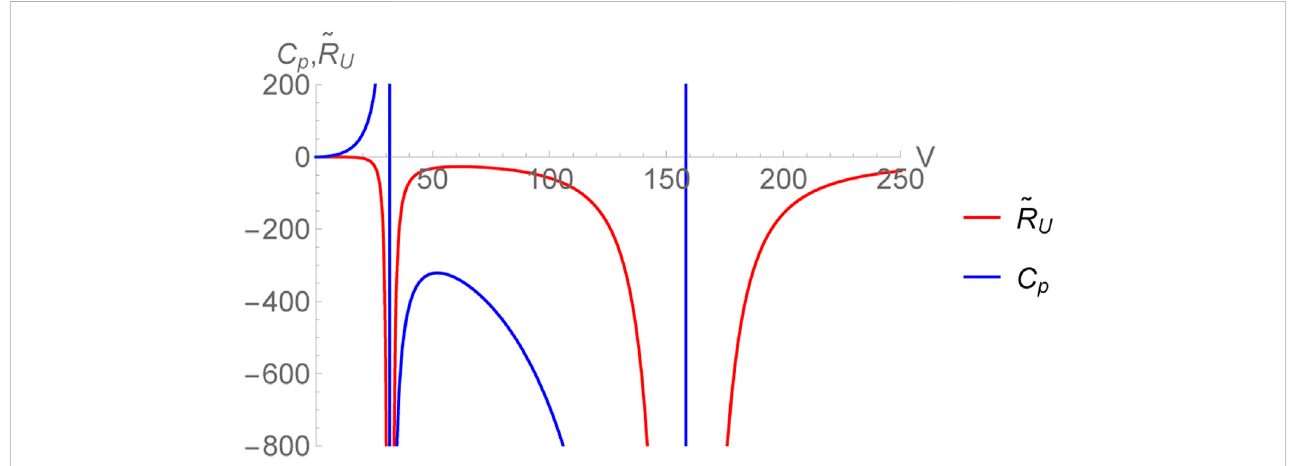
FIGURE 2 Normalized thermodynamic curvature ~ R U for the RN-AdS black hole and speci fi c heat C P plotted versus thermodynamic volume V with q =1, T =0.01.